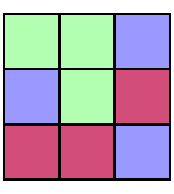
FIG. 8. An optimal classical strategy for the d = 3 Torpedo Game. Alice uses her dit of communication to indicate in which equivalence class (represented by the same colored cells) of the large grid partition she finds herself. The smaller grids (cf. Fig. 4) show where Bob chooses to shoot, given a direction and a color. For the first direction, when asked to shoot horizontally in the grid, notice that Bob may avoid Alice with certainty if she is in either of the red or green partitions. Lines that avoid Alice with certainty are depicted in the corresponding color, whereas black lines intersect with Alice’s position with probability 1 this strategy wins the Torpedo Game with probability 1 ) = 11 . 1 + 8 9 12